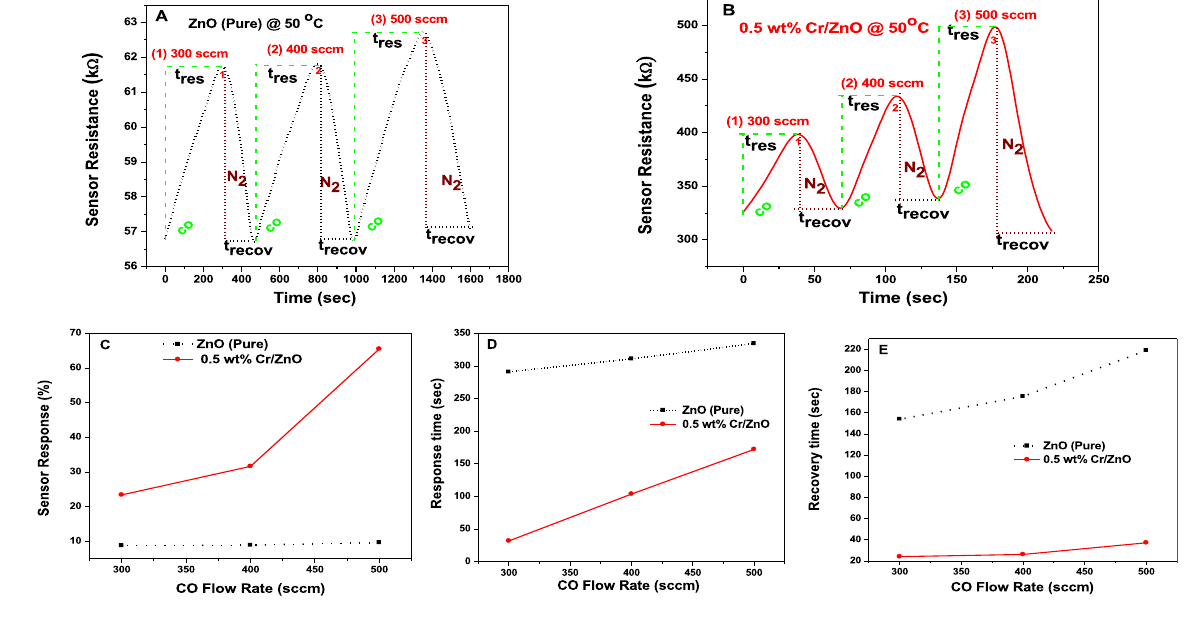
Figure 7. The dynamic response curves for ( A ) ZnO (pure) and ( B ) 0.5 wt% Cr/ZnO sensor resistance vs. the detection time; ( C ) The sensor response (%) as a function of CO concentration in sccm ( D ) Response time (t res ) and ( E ) Recovery time (t recov ) of ZnO (Pure) and 0.5 wt% Cr/ZnO sensors vs. CO concentration in sccm.